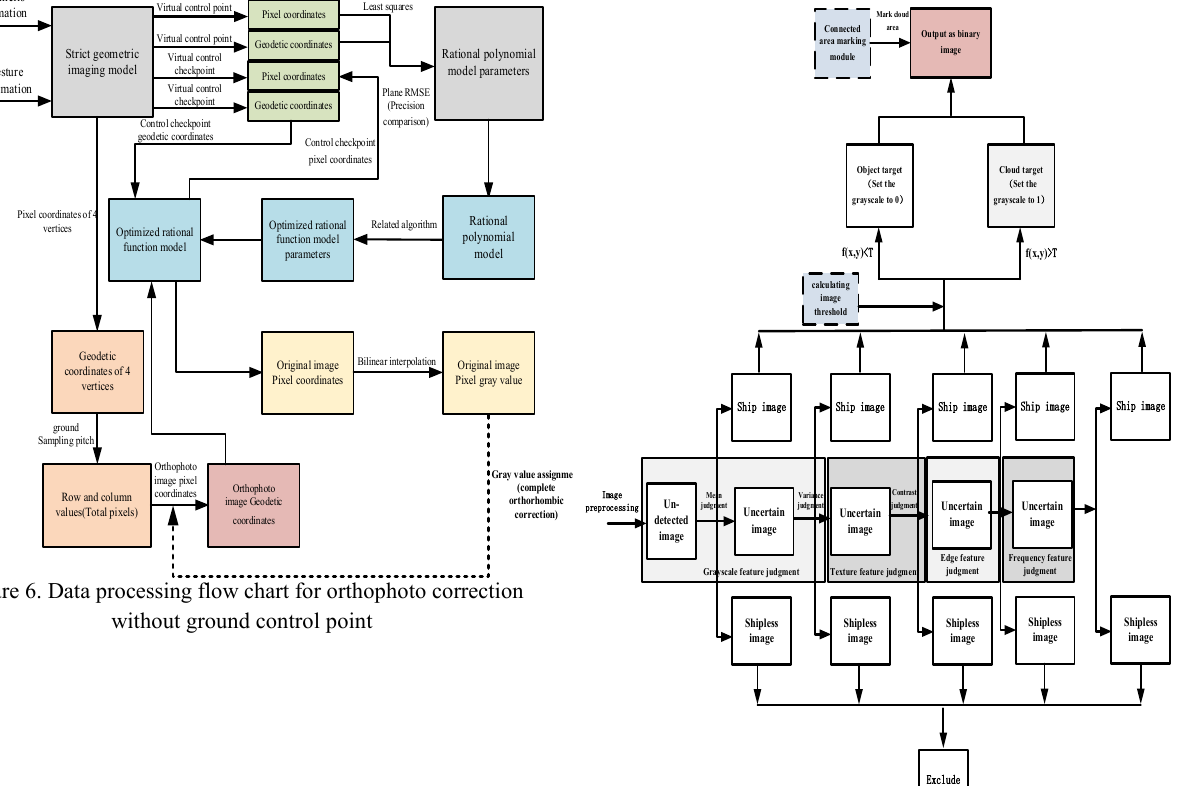
Figure 7. Ship detection data processing flow